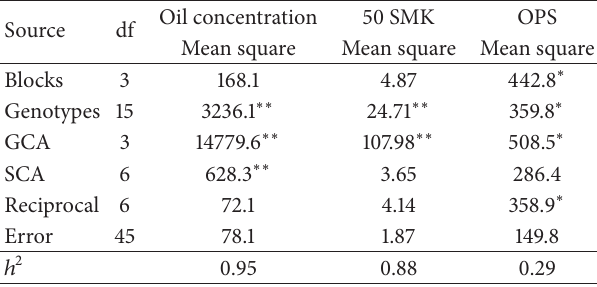
respectively. Table 3: Estimates of GCA effects and standard errors for oil con- centration in gkg − 1 , weight of 50 sound mature kernels (50 SMK) in grams, and mean milligrams oil produced per SMK (OPS) in a four-parent 𝐹 2 diallel of peanut.